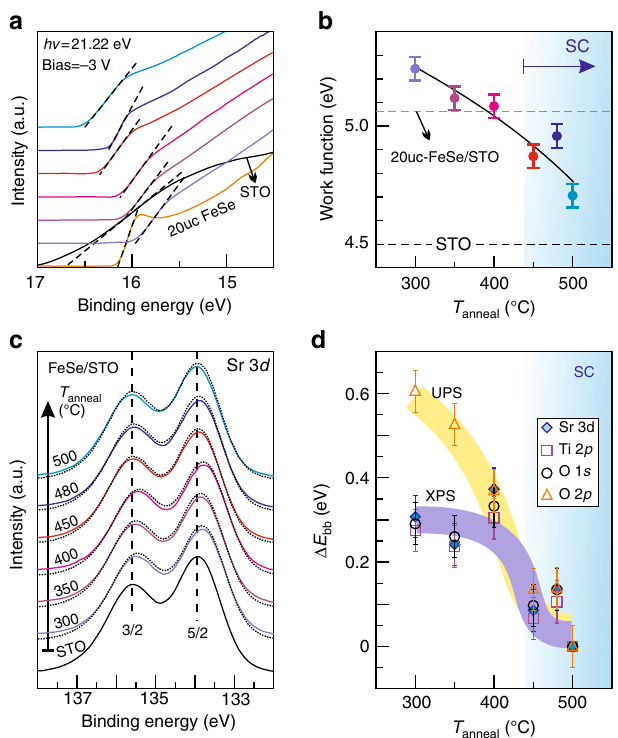
Fig. 2 Work function of FeSe/STO and band bending in STO. a SECO edge obtained with the sample biased to − 3 V and He-I light of 21.22 eV. Except for the bottom two curves, the curves are from 1uc-FeSe/STO at annealing stages in the same order as shown in Figure 1b. b Work function of 1uc- FeSe/STO as a function of annealing temperature. Dashed horizontal lines indicate the values of 20uc-FeSe/STO as well as a pristine STO, respectively. Error bars were from the energy resolution of the measurement. c Sr 3 d core level spectra of pristine STO as well as STO after the growth of 1uc-FeSe and annealed at increasing temperatures. Dotted curves are fi tted spectra described in Supplementary Fig. 9. Dashed vertical lines are guides to the eye. d Fitted band bending values at